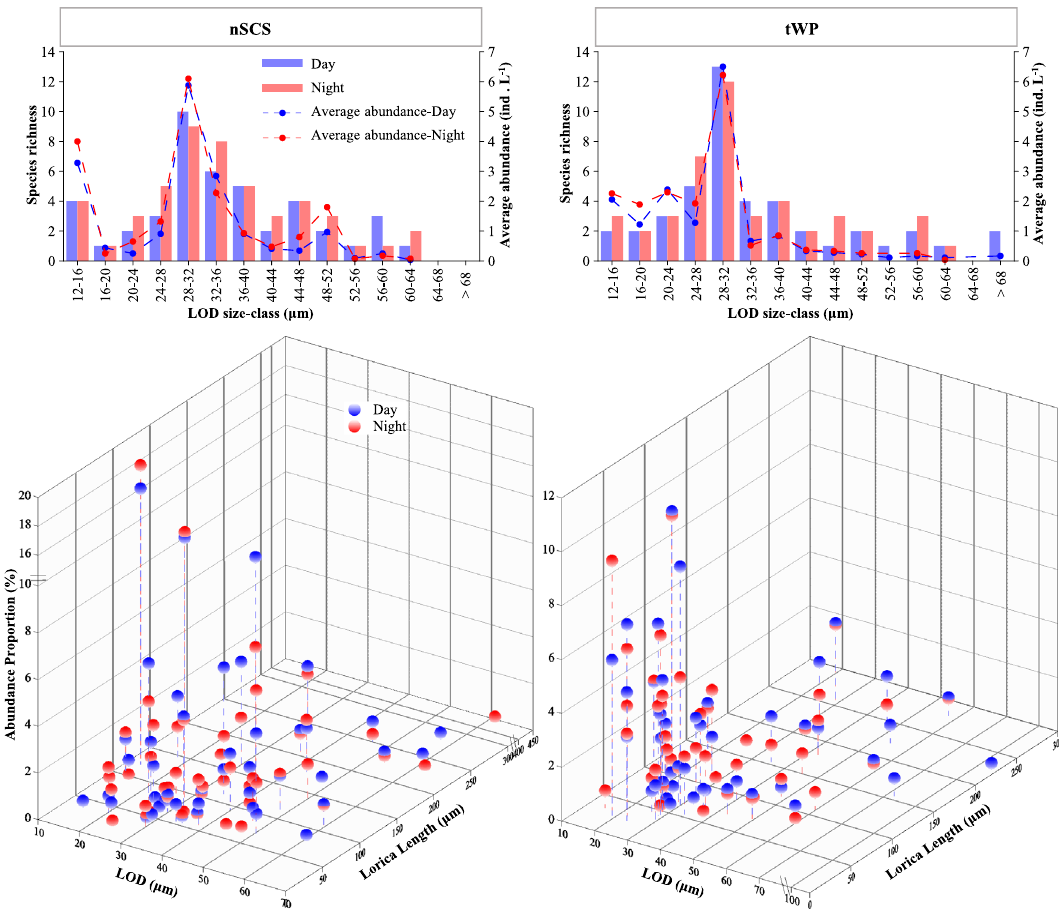
Figure 5. Day-night variations of tintinnid species richness, lorica oral diameter (LOD), lorica length, average abundance and abundance proportion in the nSCS and